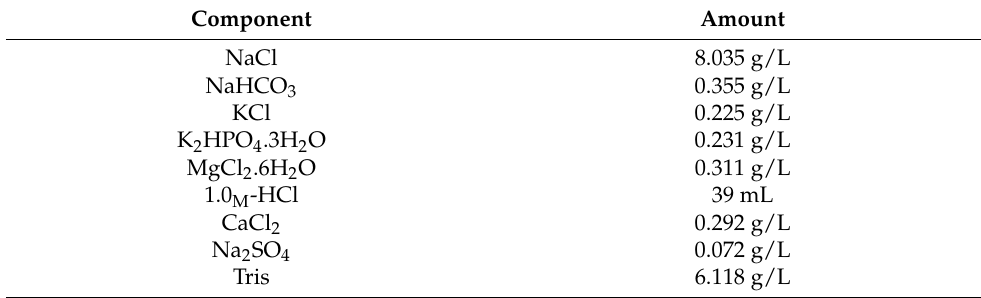
Table 2. The chemical composition of SBF solution used in tribological